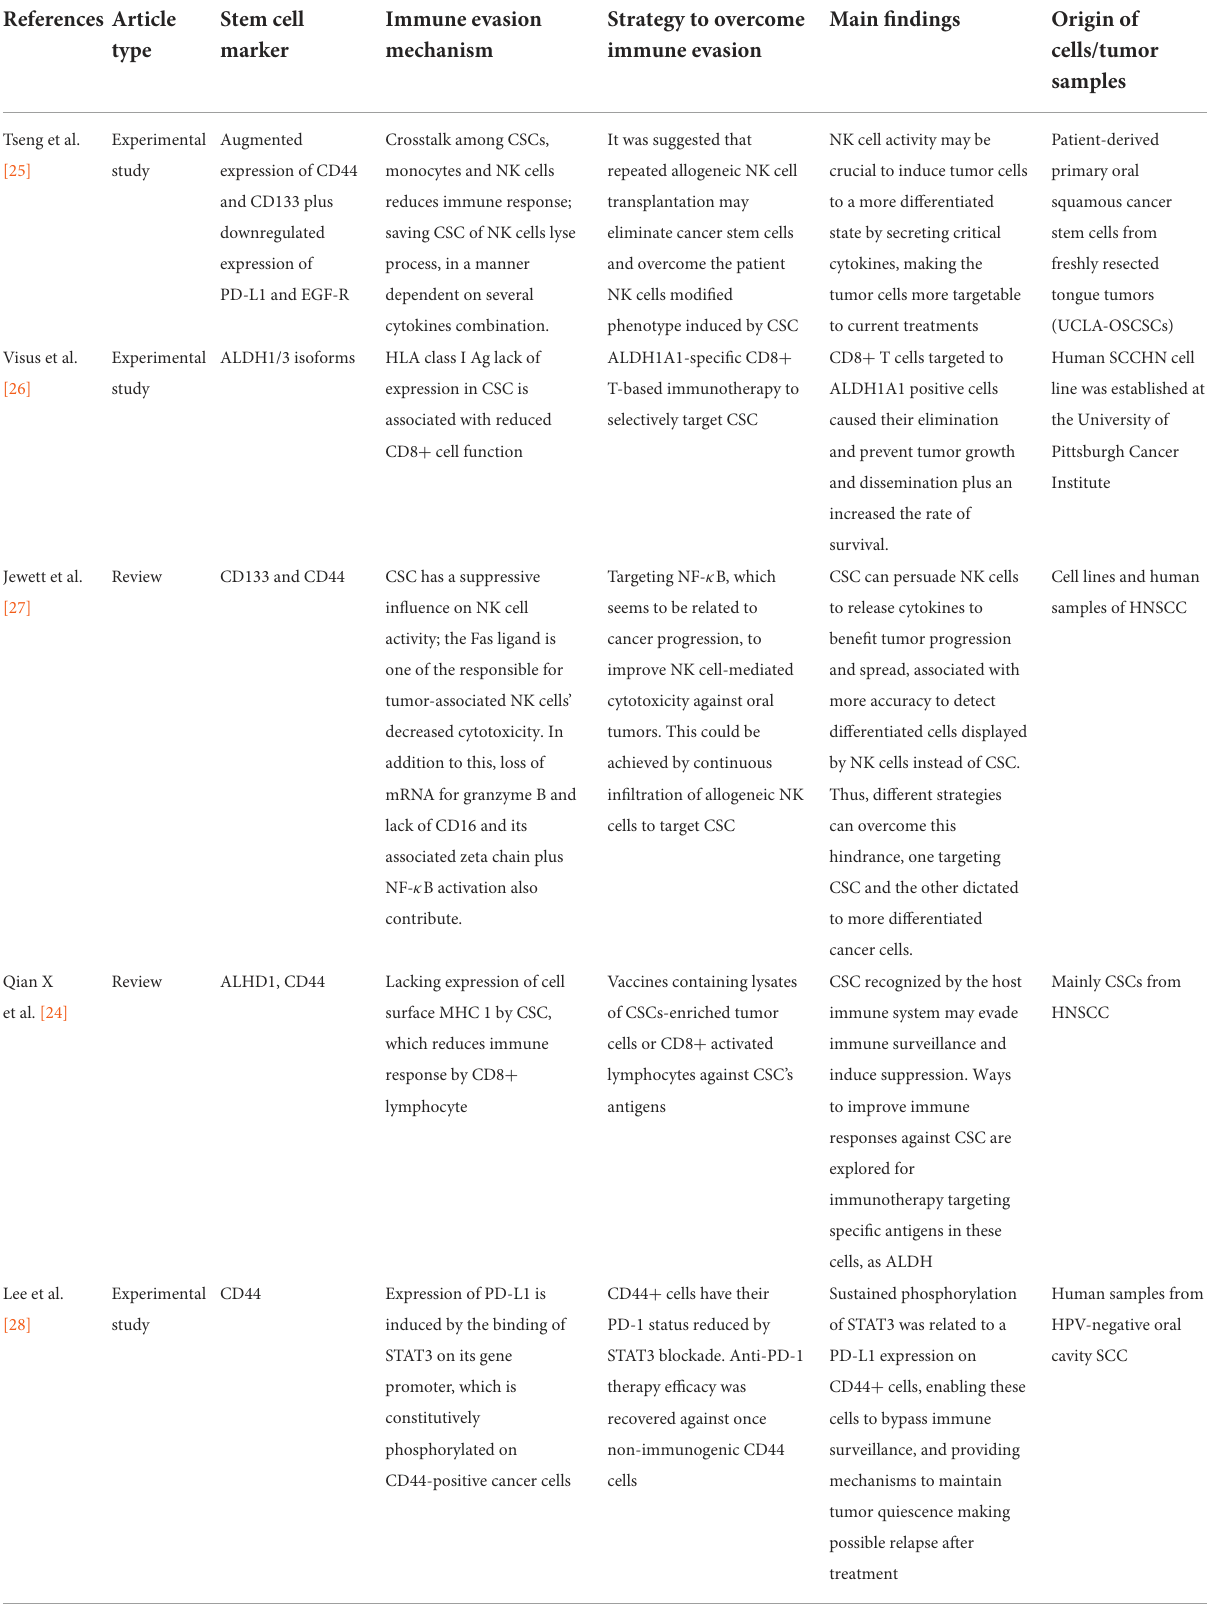
TABLE 1 The main immune evasion mechanisms and strategies to overcome immune evasion in oral and head and neck cancer stem